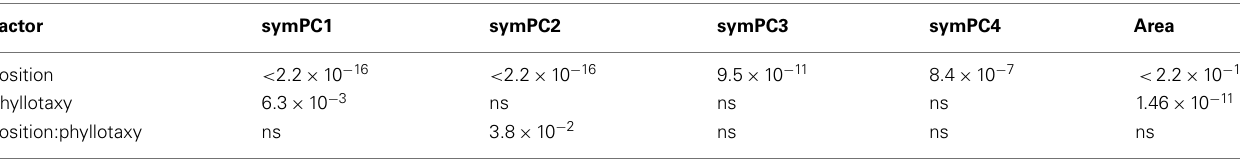
Table 2 |ANOVA results for leaf area and PCs explaining symmetric